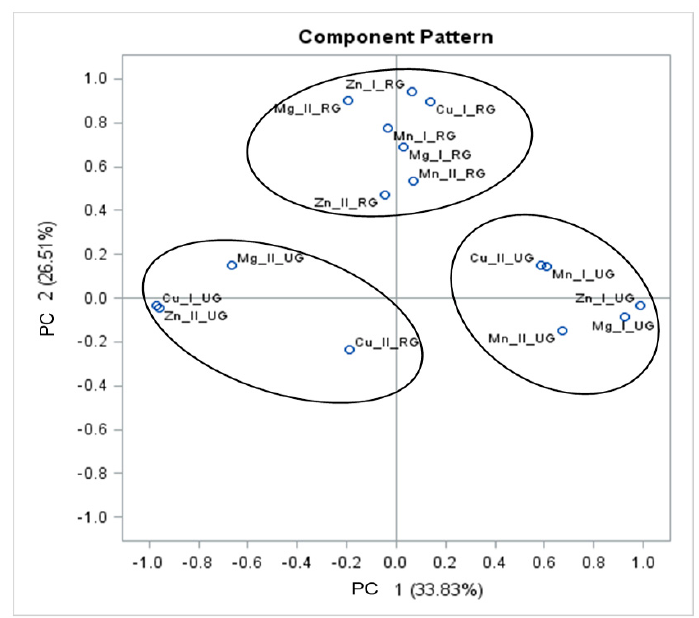
Figure 5. Principal component analysis in assessment of total content of analysed minerals and their amount released by in vitro digestion of buckwheat groats. Explanatory notes: Mg I, Mn I, Zn I, Cu I—total content of minerals in buckwheat groats; Mg II, Mn II, Zn II, Cu II—content of minerals released by in vitro digestion of buckwheat groats; RG—roasted groats; UG—unroasted groats.